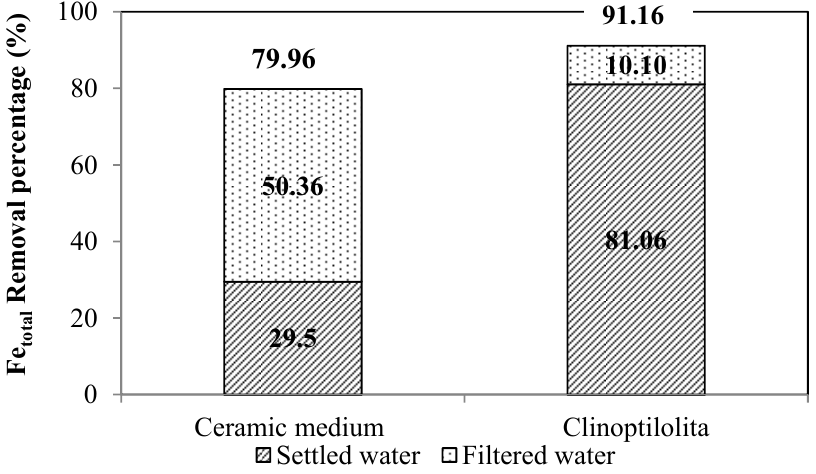
Figure 9. Iron removal in full-scale NCMG plant for configurations A and B.